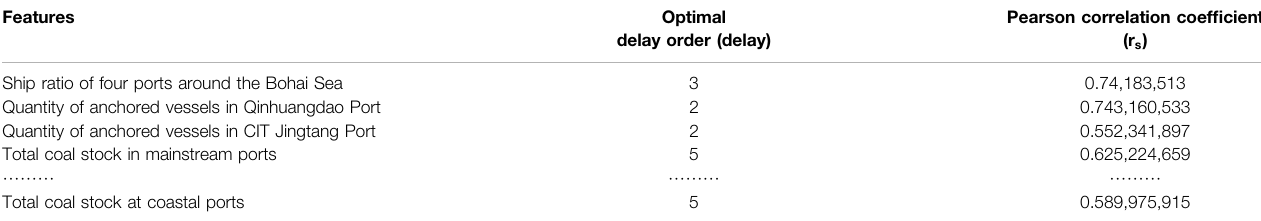
TABLE 4 | Nonlinear features with optimal delay. Features